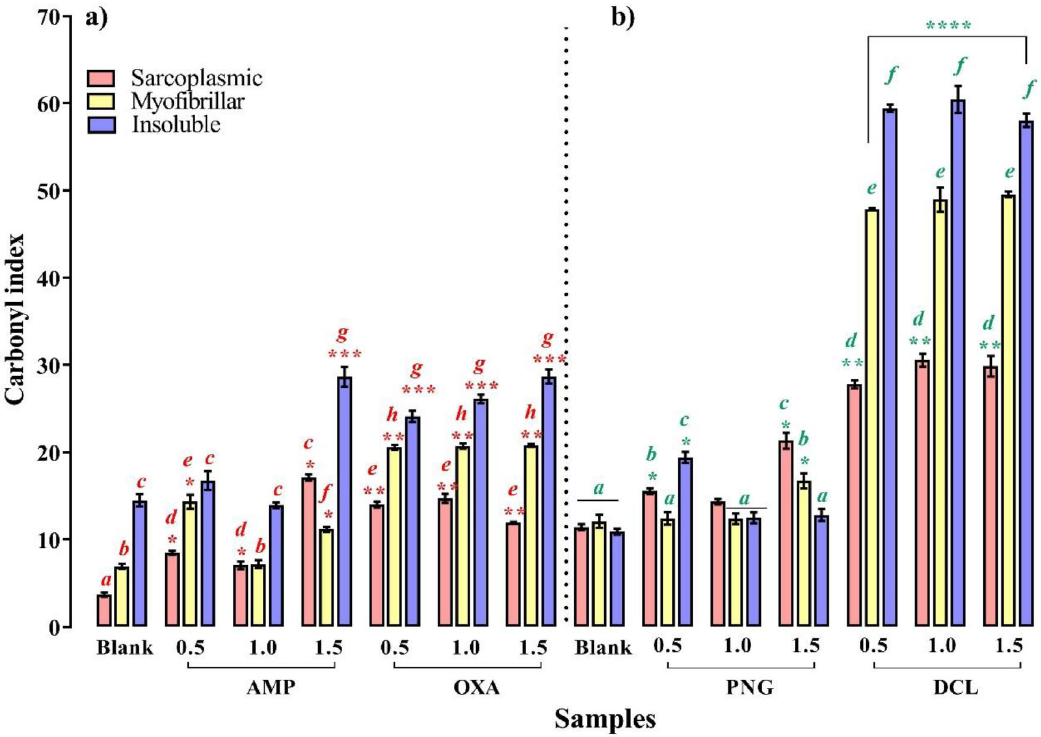
Figure 3. Changes in carbonyl content of sarcoplasmic, myofibrillar and insoluble chicken breast proteins inducedbyampicillin(AMP),penicillin(PNG),oxacillin(OXA)anddicloxacillin(DCL). Meanvalues (cid:4) SEM.Letters a-j above the bars denote statistically significant differences in carbonylation compared to blank. Means having different superscripts differ between blank and tetracyclines concentration ( p < 0.05). **** p < 0.0001, *** p < 0.005, ** p < 0.05 denote statistically significant differences among treatment and their respective